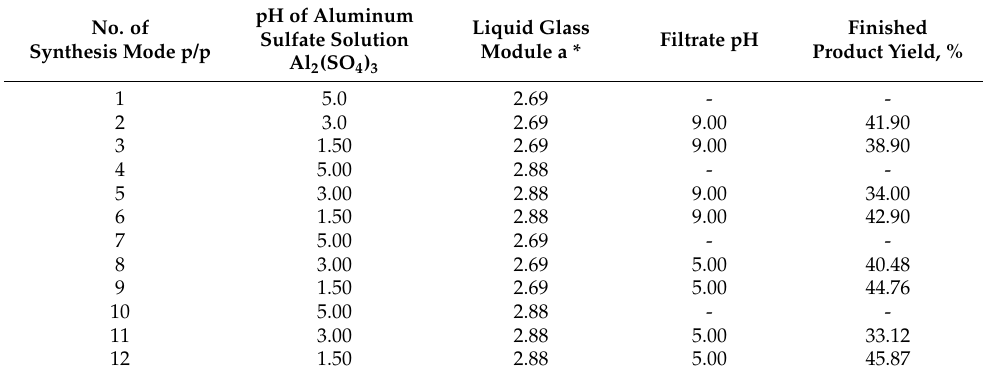
Table 1. Aluminosilicates synthesis